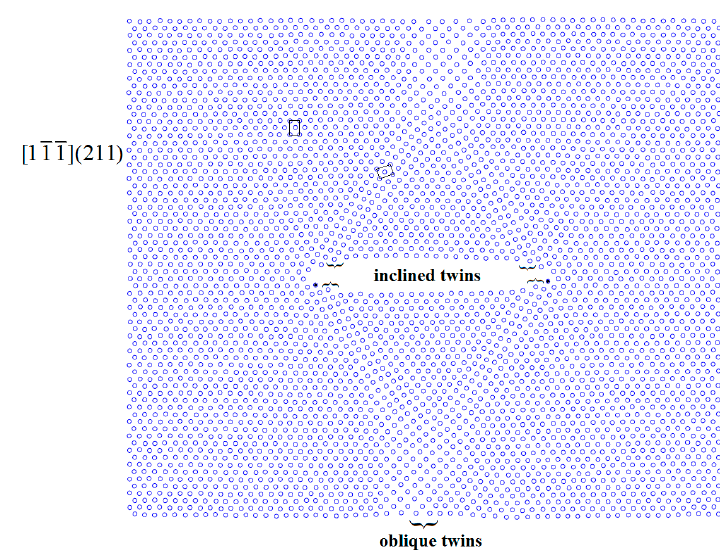
Figure 11. Temperature 600 K, α = 1.2: easy and oblique twinning above and below the crack faces, time step 5500 ( ∆ t = 4500 h , K A (t) = 0.517 MPa·m 1/2 ). The primary crack tip atoms are denoted by black.